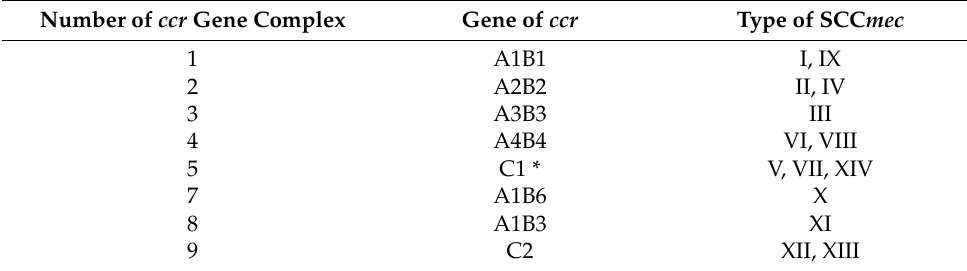
Table 2. ccr gene comlexes in S. aureus .